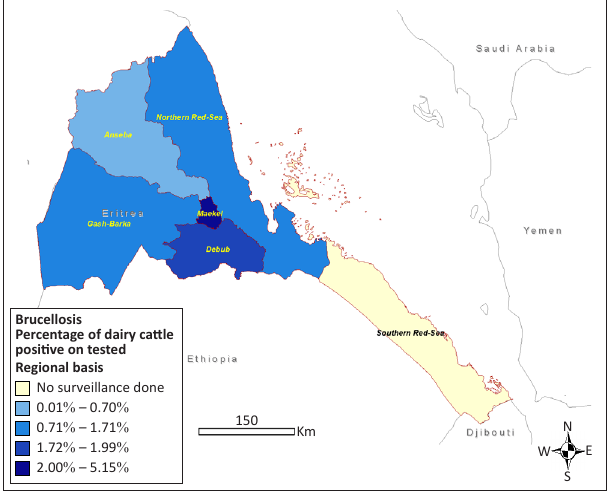
FIGURE 1: Geographical distribution of test results for brucellosis in dairy cattle in Eritrea at regional level in 2009.